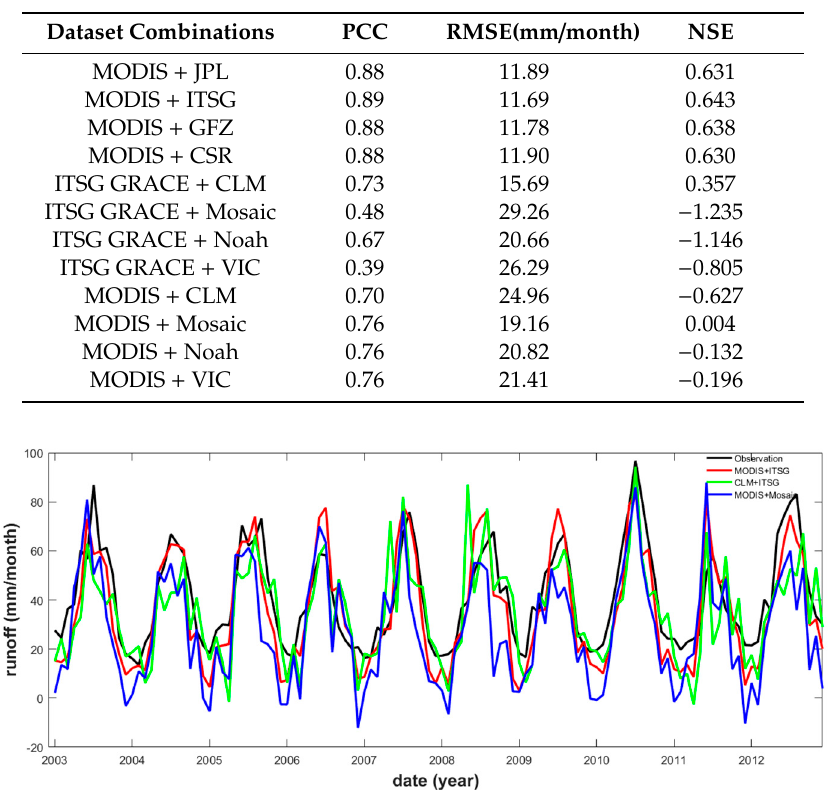
Figure 6. GRACE terrestrial water storage and the GLDAS-modeled time series in correspondence of ( a ) Pingshan (upper reaches), ( b ) Chenglingji (middle reaches), and ( c ) Datong (lower reaches) stations. Table 5. Statistical comparison between the remotely sensed GRACE (CSR) and the GLDAS-modeled terrestrial water storage datasets at the three selected stations along the upper, middle, and lower reaches of the Yangtze River basin.